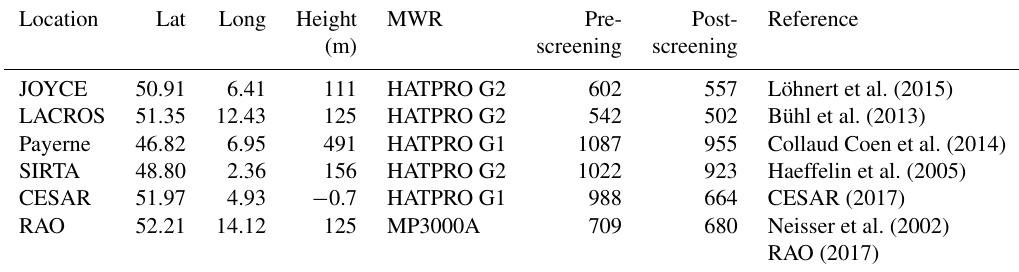
Table 1. Sample size at all the instrumental sites before and after the quality control screening. Position, height, and reference of each instrument are reported. For HATPRO only, the generation family is also reported (G5 is currently commercialized). Location Pre- Post- Reference screening screening